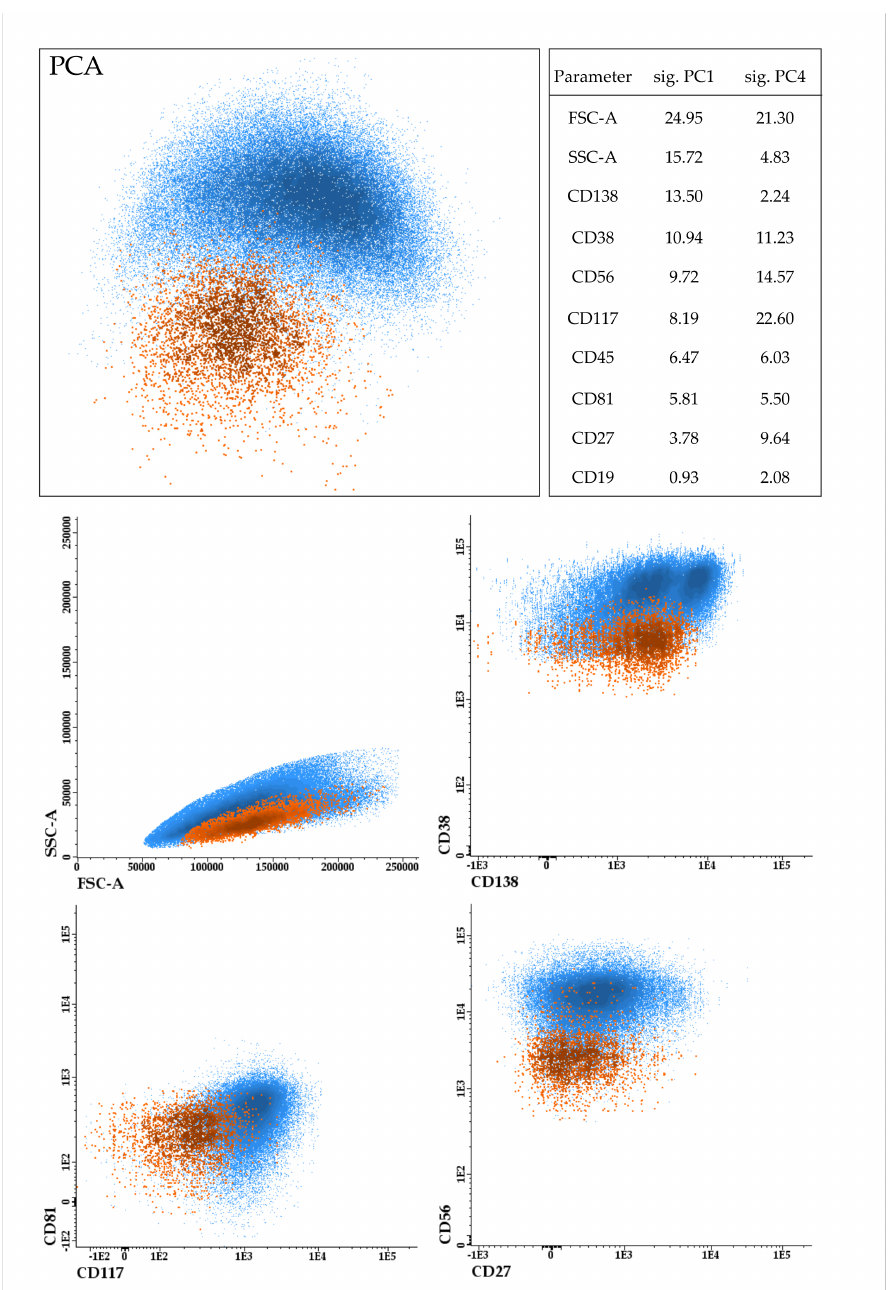
Figure 1. Example of the immunophenotypic features of paired bone marrow (BM) tumor cells, in green, and circulating tumor cells (CTCs), in red, from a representative patient. Results are represented by principal component analysis (PCA) based on the expression levels of eight antigens (CD19, CD27, CD38, CD45, CD56, CD81, CD117, CD138) together with forward (FSC) and side scatter (SSC). The significance (sig.) of each parameter in discriminating cells with different phenotypes is represented in the table. Of note, BM tumor cells are composed of two clones with negative and positive expression of CD138 and different morphology (FSC and SSC), whereas only CTCs without CD138 have egressed into circulation. Furthermore, CTCs show downregulation of CD38, CD56, CD81 and CD117 when compared to BM tumor